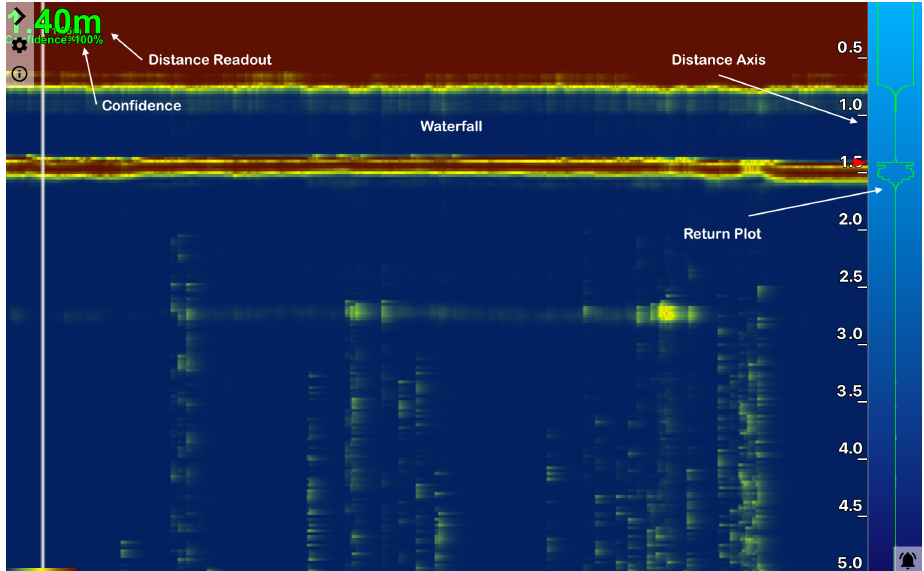
Figure 19. Ping-Viewer Interface to View and Record Ping Data showing Water Depth: consists of four important components (Distance Readout, Distance Axis; echo strength and 3D trace presenting consecutive profile